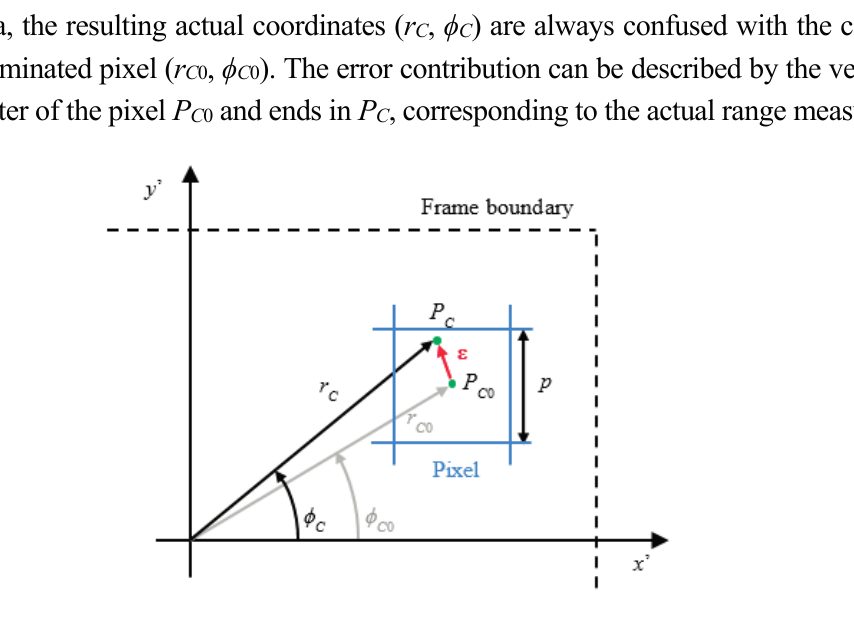
Figure 3. Error components related to the quantization of the image plane due to the finite area of pixels. Each pixel of the plane is square and has side equal to the pixel pitch p